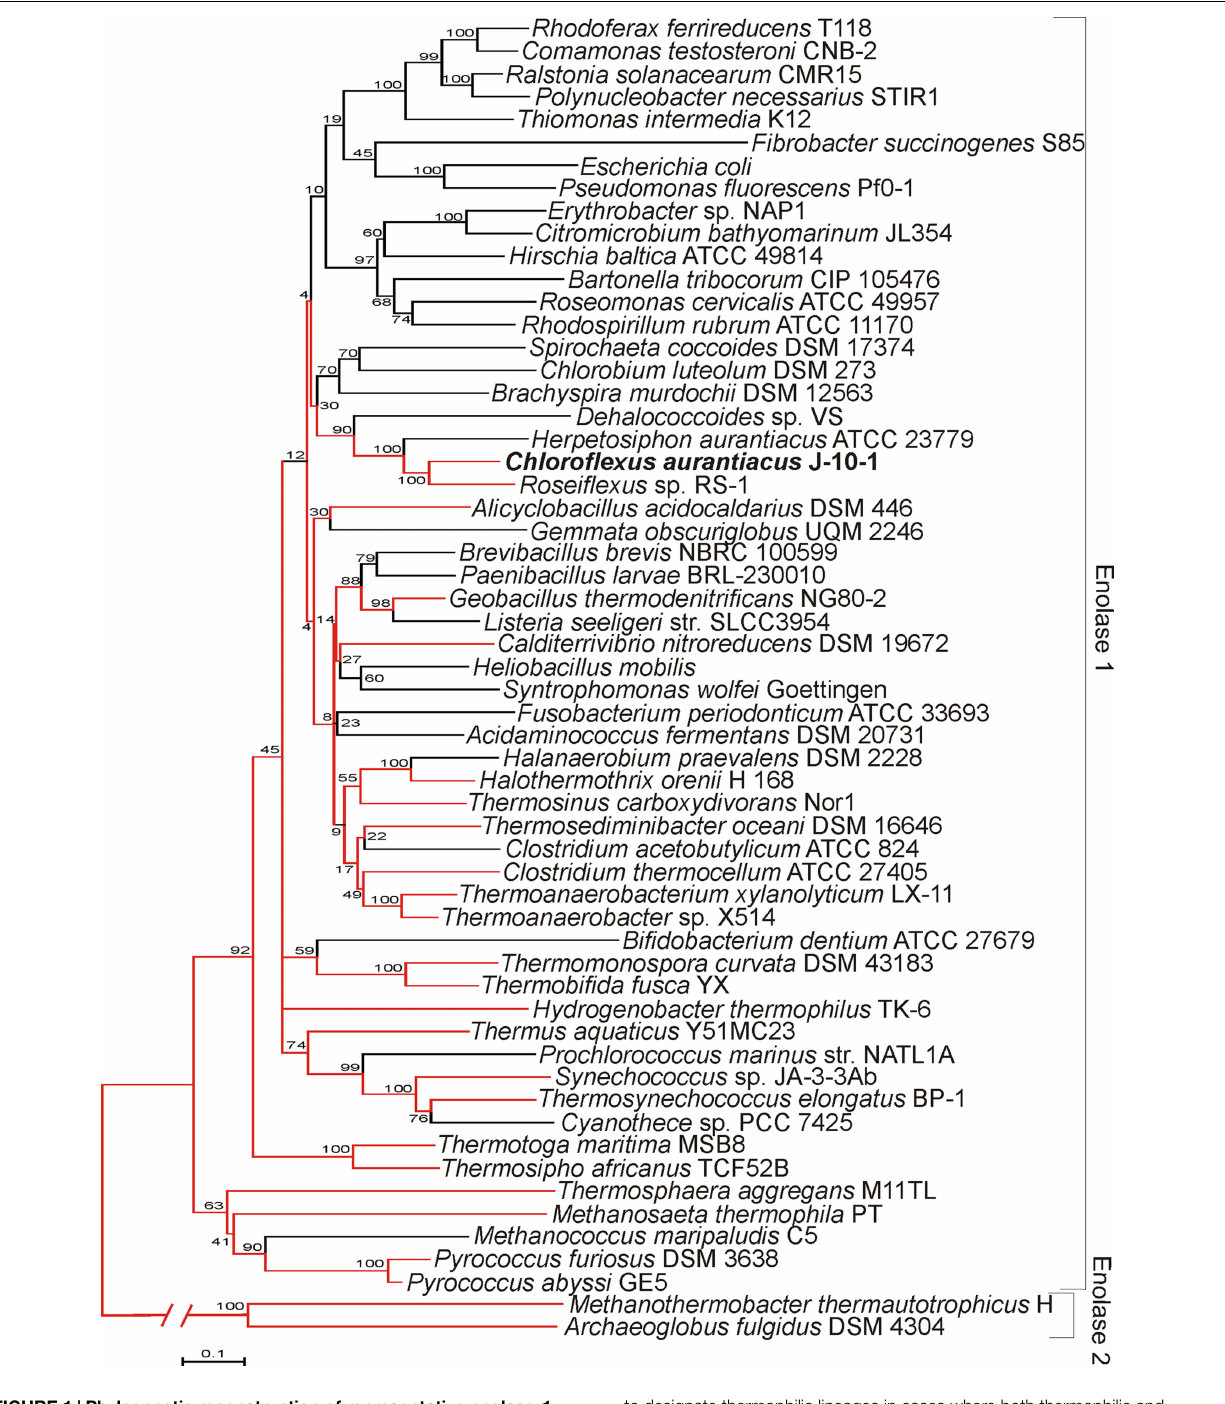
FIGURE 1 | Phylogenetic reconstruction of representative enolase-1 sequences as determined using the neighbor-joining method . Lineages represented by thermophiles are colored red. Parsimony was used